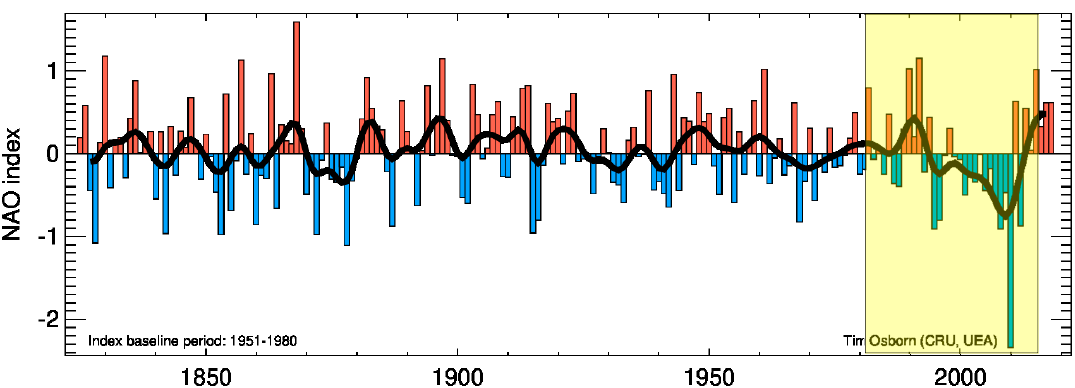
Figure 8. Annual NAO index 1825–2019 relative to the 1951–1980 average index value (0 on this plot). Our study period has been highlighted in yellow; updated and adapted from Osborn [65].